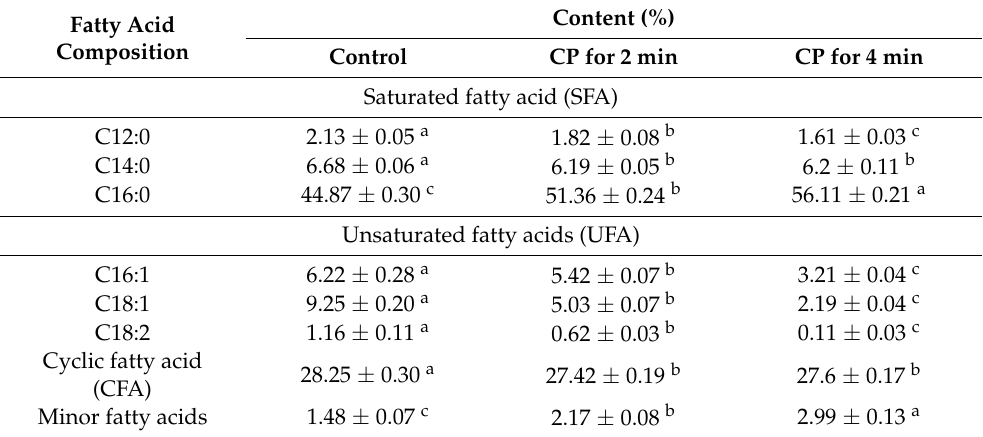
Table 1. Effects of DBD plasma treatment on the fatty acid composition of S. typhimurium cell.